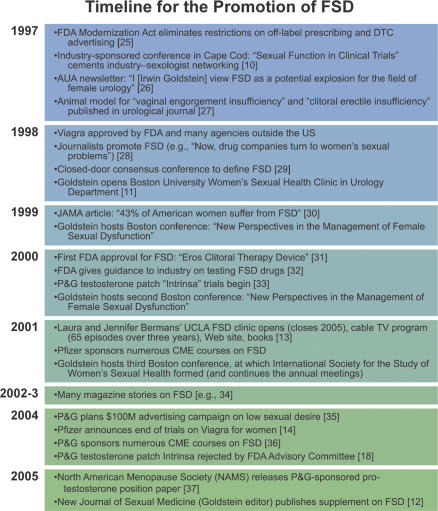
Timeline for the Promotion of FSD from 1997 to PresentAUA, American Urological Association; CME, Continuing Medical Education; JAMA, Journal of the American Medical Association (Figure: Rusty Howson)